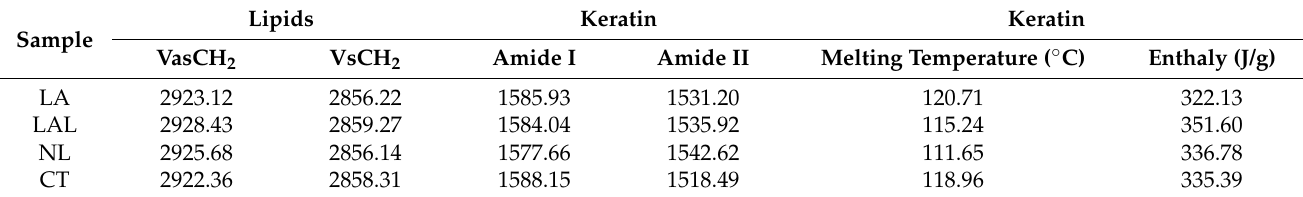
Figure 3. ( a ) FTIR spectra of skin samples treated with different formulations; ( b ) the DSC thermograms of skin samples after treatment with LALs and other formulations. Table 1. Peaks of SC lipids and keratin of skin samples after treatment with different formulations.